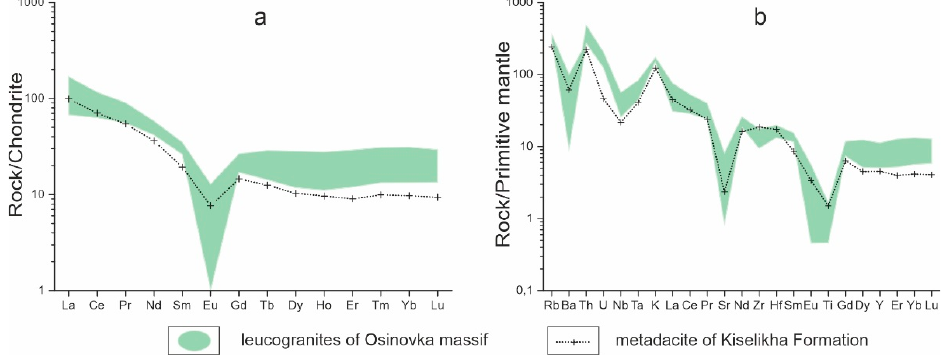
Figure 17. Chondrite-normalized REE patterns [98] ( a ) and primitive mantle-normalized spider- grams [99] ( b ) for rocks of Osinovka massif compared to metadacite from the Kiselikha Group.